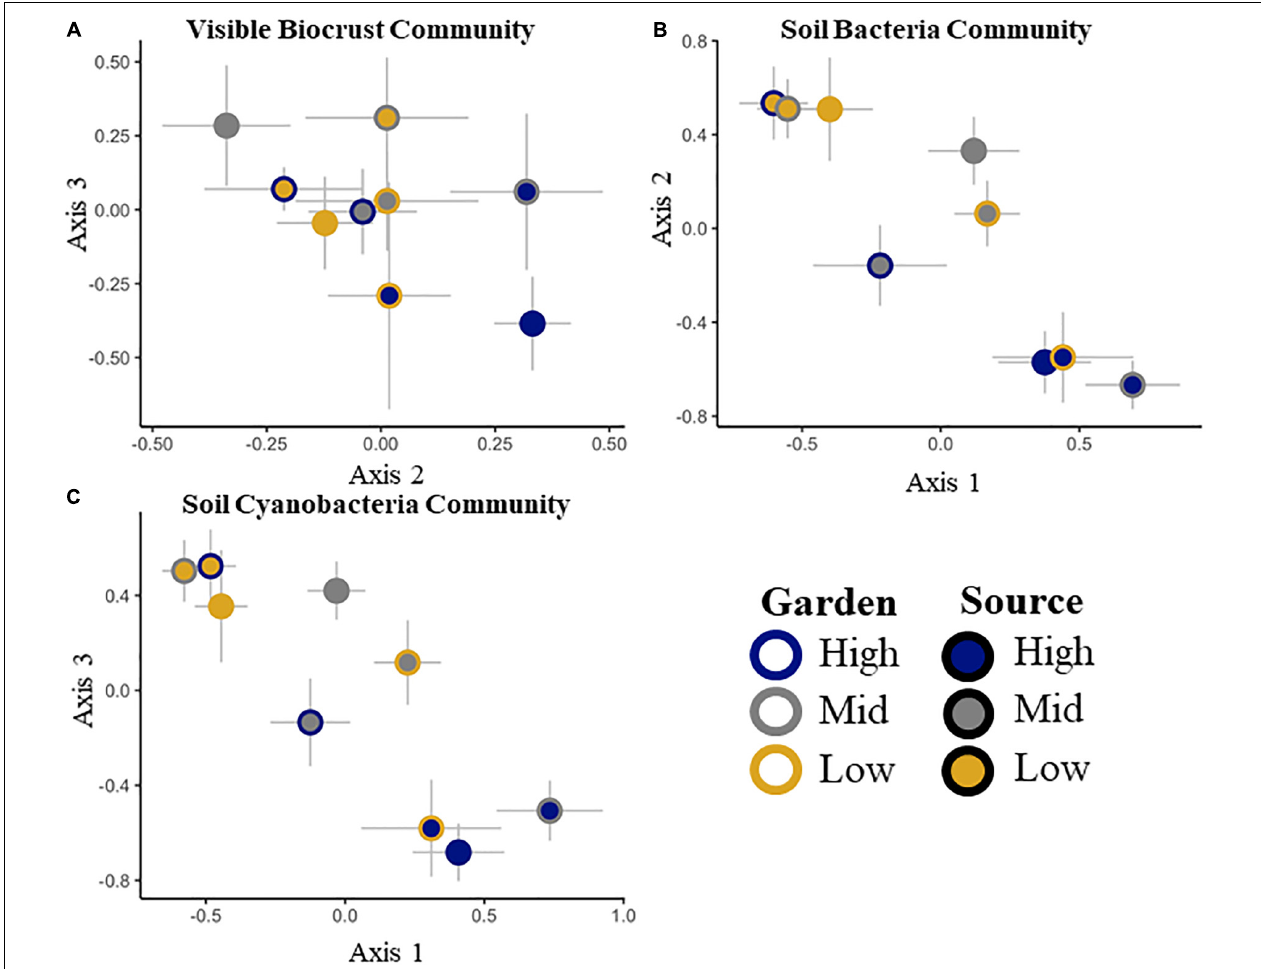
FIGURE 1 | Non-metric multidimensional scaling ordinations of the visible biocrust cover community (A) , the total soil bacterial community at the family level (B) and the soil cyanobacterial only community at the family level (C) . Two of three dimensions are shown, with axes labeled, stress < 0.2 in all cases. Signed axis correlation coefficients are given for taxa correlating at r > 0.2, with negative correlations on the left, and positive correlations on the right below each x-axis. No correlations met the criteria for the axis not